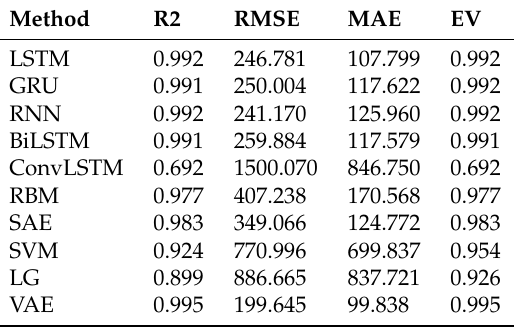
Figure 9. Scatter graphs of PV power forecasting and measurements using the eight models: ( a ) LSTM, Table 4. Forecasting performance of the eight methods using the test set of the second